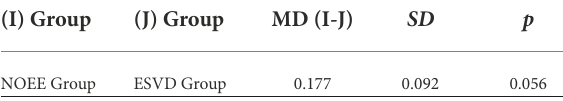
TABLE 8 Paired comparisons for the NOEE and ESVD